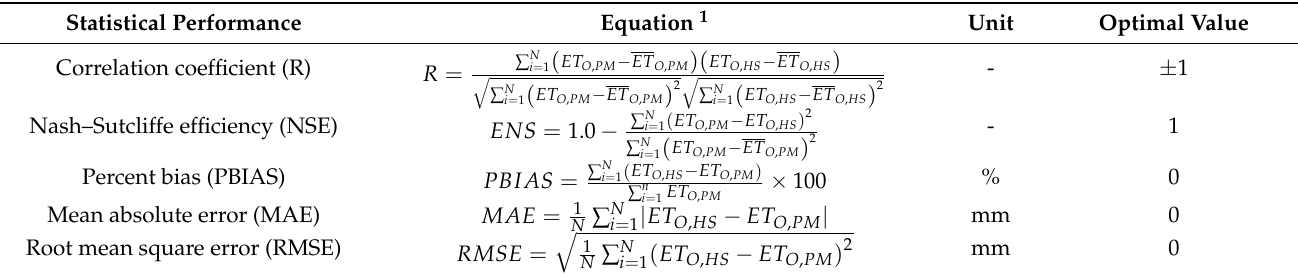
Table 2. List of statistical performance metrics used for the calibration and validation of the K RS of the HS equation for the estimation of